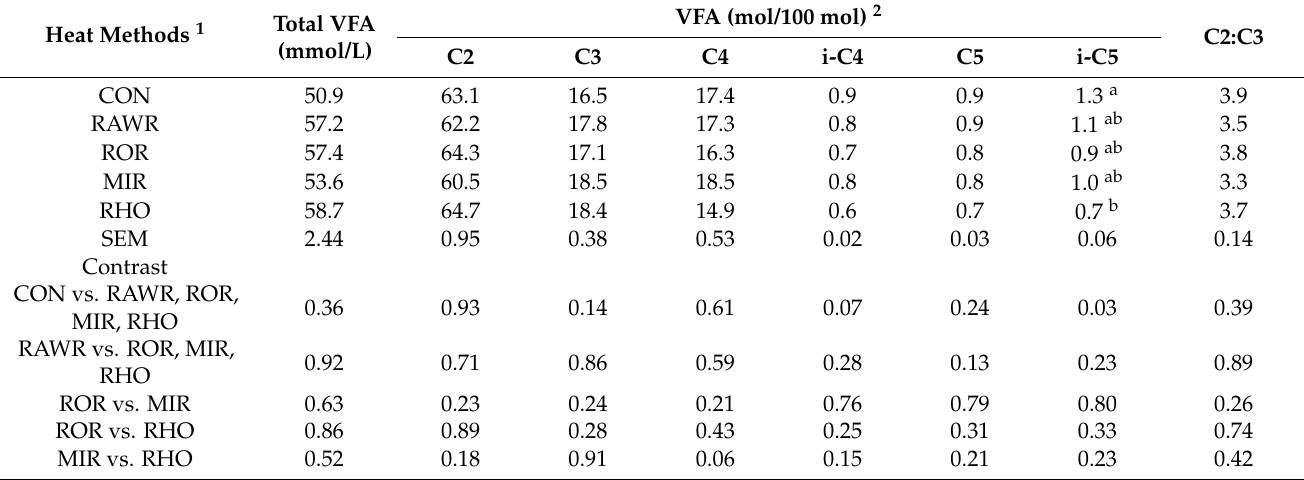
Table 5. Effect of different heated rubber seed kernel on volatile fatty acid (VFA) in the rumen.